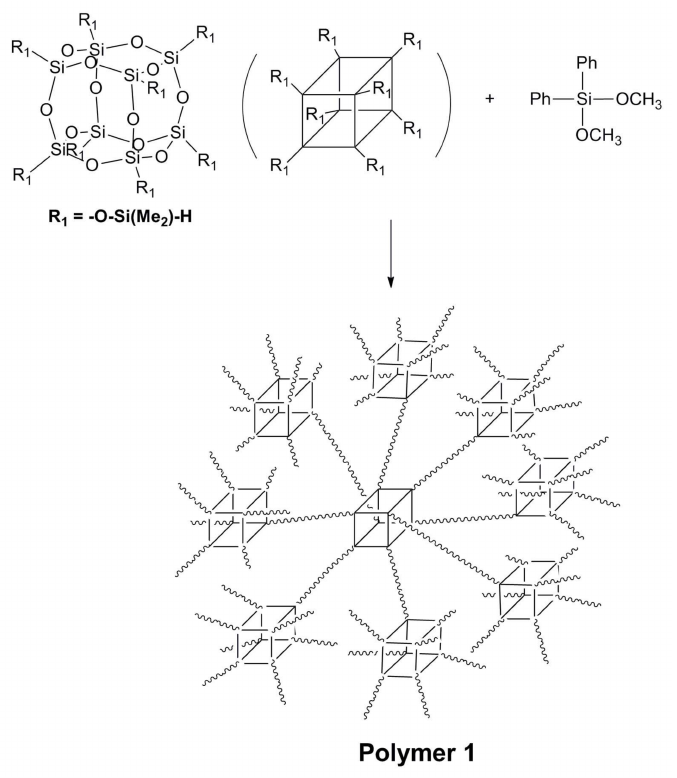
Scheme 1. Reaction scheme to prepare polymer 1